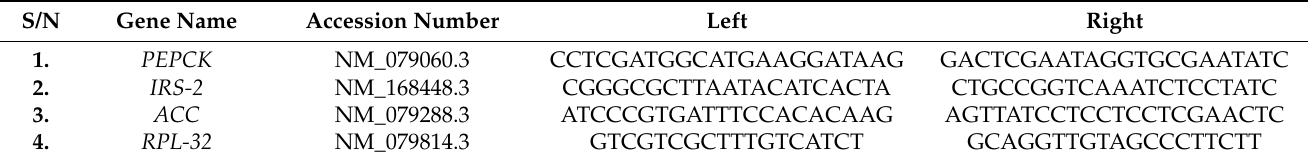
Table 4. Gene name, accession number and primer sequences used in the analysis of drosophila melanogaster